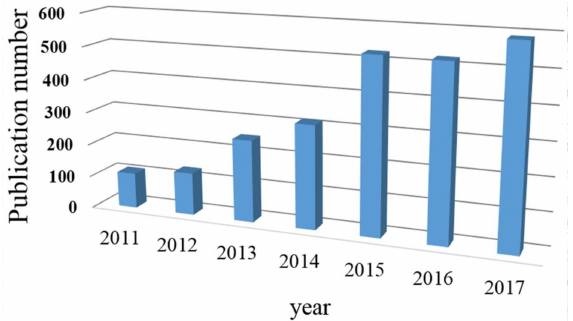
Figure 2. Publications related to the nanoparticles cited in this review (TiO 2 , CNTs, Ag, Cu, GO, and ZnO until 8 October 2017; data acquired from https://www.scopus.com and